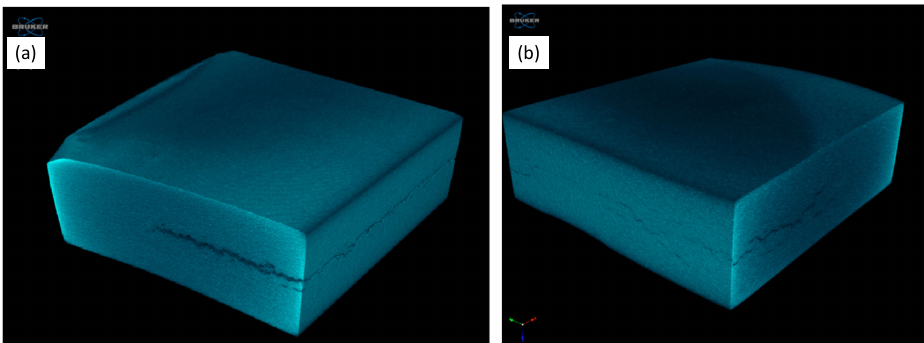
Figure 12. X-ray microCT scans of soft recovered ( a ) 5083-H321aluminum and ( b ) 5083-ECAE + 30% CR aluminum samples shock compressed to approximately 1.46 GPa [14].